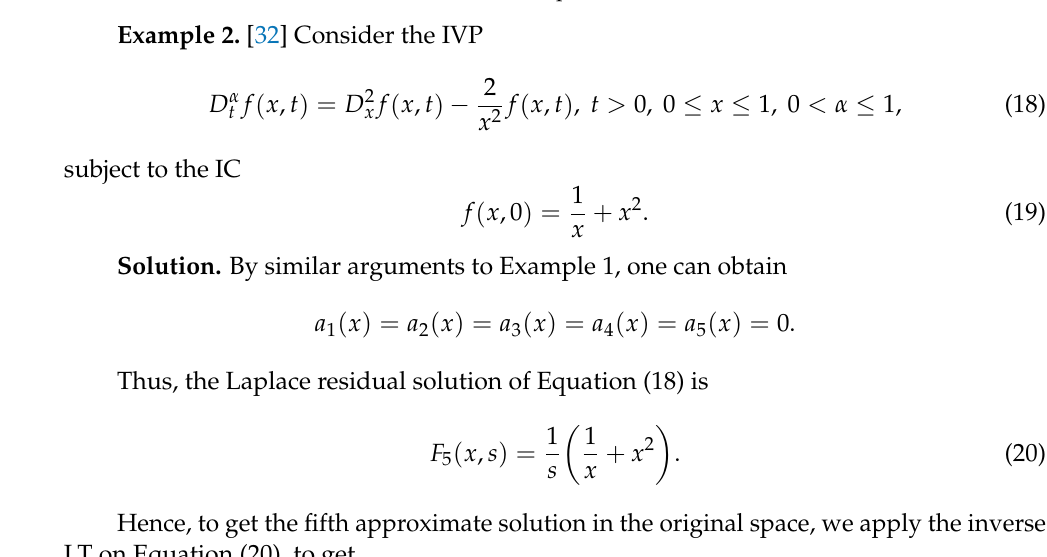
Figure 2. The contour graph of the solution f ( x , t ) of the fractional equation of the cancer tumor model at r = − 1.2 and several values of α in Example 1. ( a ). α = 1; ( b ) α = 0.9; ( c ) α = 0.8; ( d ) α =